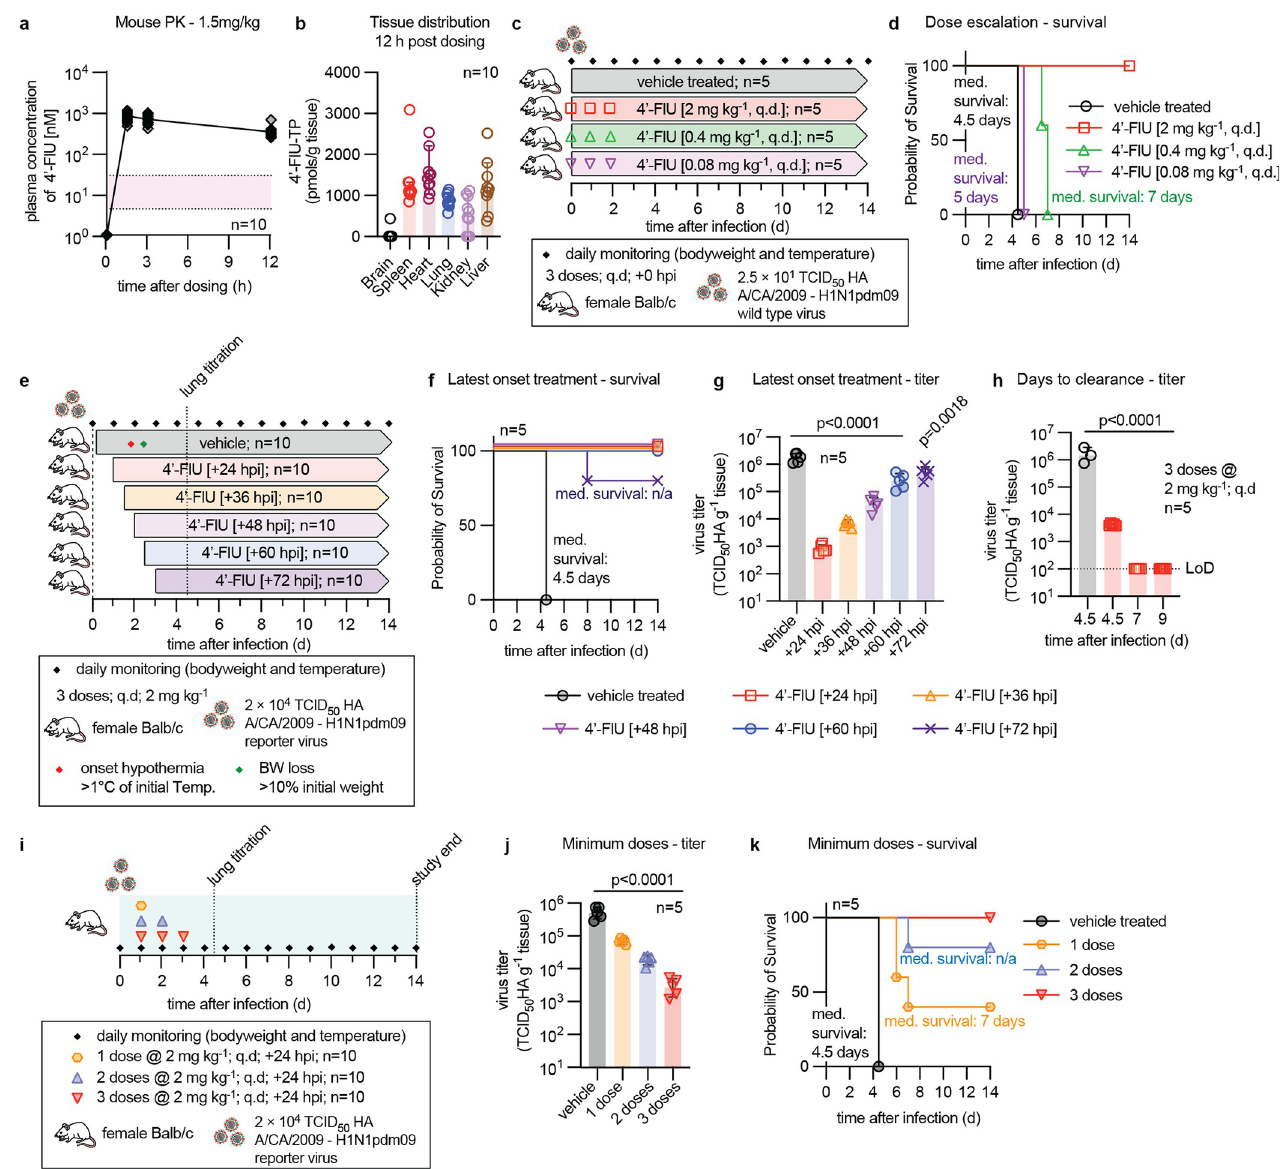
Fig 2. Treatment paradigms of 4’-FlU in mice. a) Mouse plasma exposure after a single oral dose of 1.5 mg/kg bodyweight. The red area denotes cell culture EC 90 ± 1 × SD against WSN, all donors as shown in (S1A Fig). b) Tissue distribution of bioactive anabolite 4’-FlU-TP in animals shown in (a) 12 hours after dosing. c) Schematic of dose-to-failure study against standard recA/CA/2009 (H1N1). d) Survival of animals treated as specified in (c). Median survival (med. survival) time in days is specified; Kaplan-Meier simple survival analysis. e) Study schematic to determine the therapeutic time window of oral 4’-FlU in mice, using recA/CA/2009-maxGFP-HA (H1N1) as viral target. f) Survival of animals treated as specified in (e). Median survival time in days is specified; Kaplan- Meier simple survival analysis. g) Lung viral load of a set of animals treated as in (e) was determined 4.5 days after infection. h) Time-to-viral-clearance study. Mice were infected and treated with 4’-FlU at 2 mg/kg starting 24 hours after infection and continued q.d. Lung virus load was determined in vehicle-treated animals 4.5 days after infection, and in 4’-FlU-treated animals 4.5, 7, and 9 days after infection. i) Schematic of minimal-number-of-doses finding study. j) Lung viral load of animals treated as in (i), determined 4.5 days after infection. k) Survival of a set of animals treated as in (i). Median survival time in days is specified; Kaplan-Meier simple survival analysis. Columns in (b) represent data medians with 95% CI, columns in (g-h,j) represent geometric means ± SD; symbols specify individual animals; statistical analysis in (g-h,j) with 1-way ANOVA with Dunnett’s post hoc test.